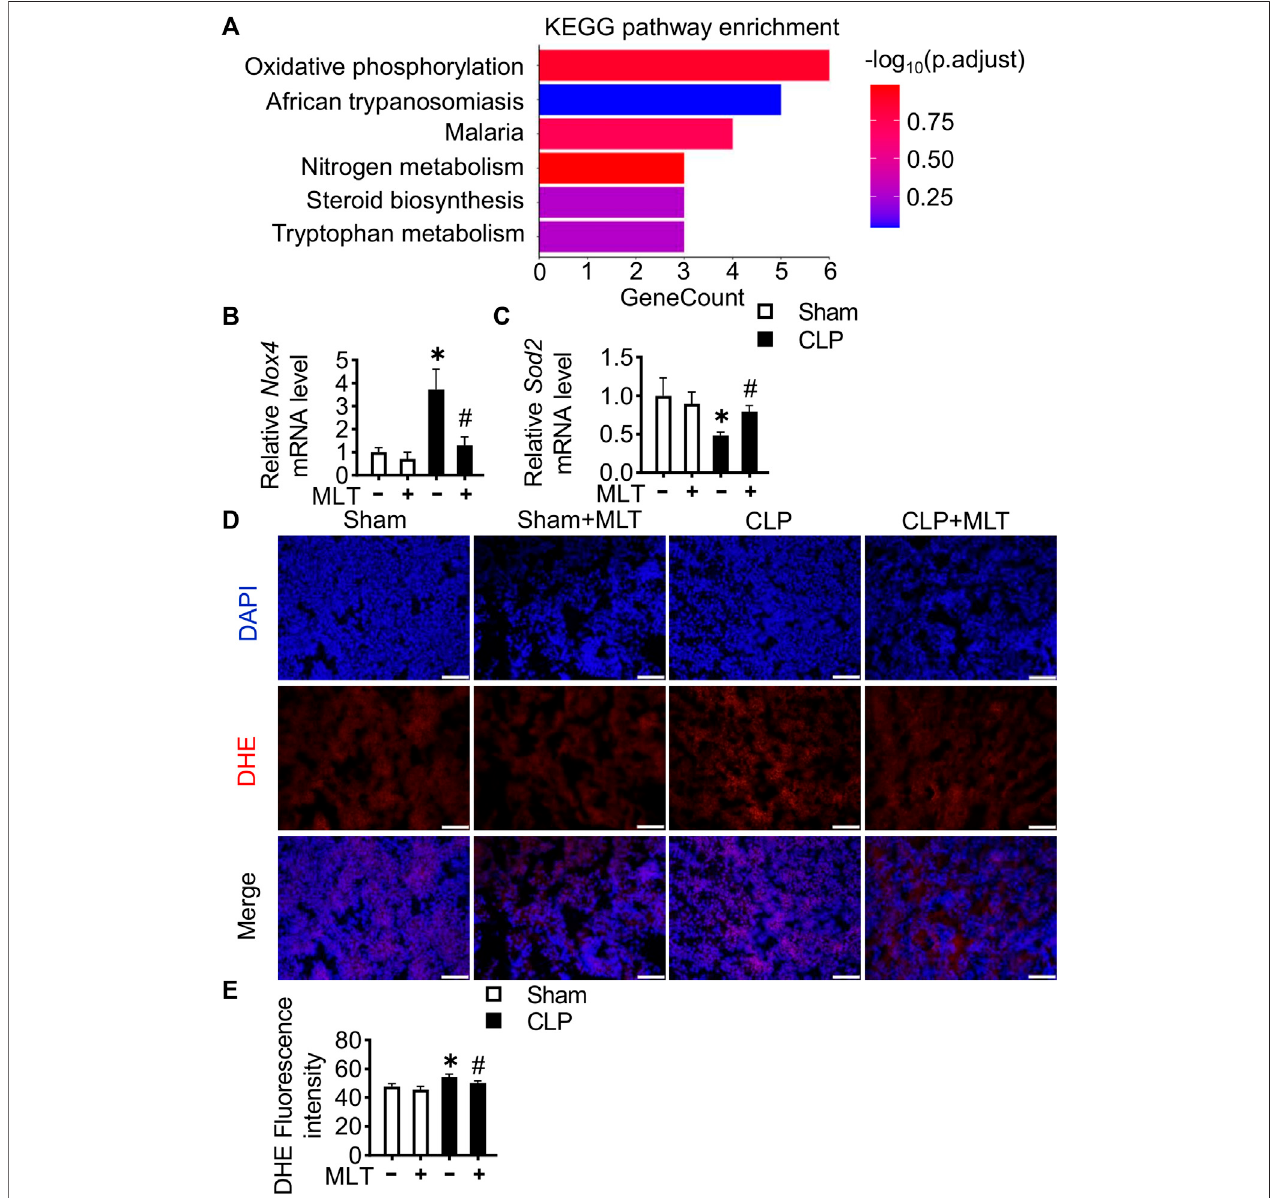
FIGURE3| Melatonin reducesROSinCLP-inducedmice. (A) KEGGannotationforthedifferentially expressed genesbetweentheCLPgroup andtheCLP+MLT group. Kidney tissue Nox4 (B) and Sod2 (C) mRNA levels are measured using RT-PCR (* vs. sham, p < 0.05; # vs. CLP, p < 0.05). (D) Representative images of DHE staining of kidney tissues (scale bar (cid:1) 200 µm). (E) ROS production was quanti fi ed and presented as the mean fl uorescence intensity (* vs. sham, p < 0.05; # vs. CLP, p < 0.05).